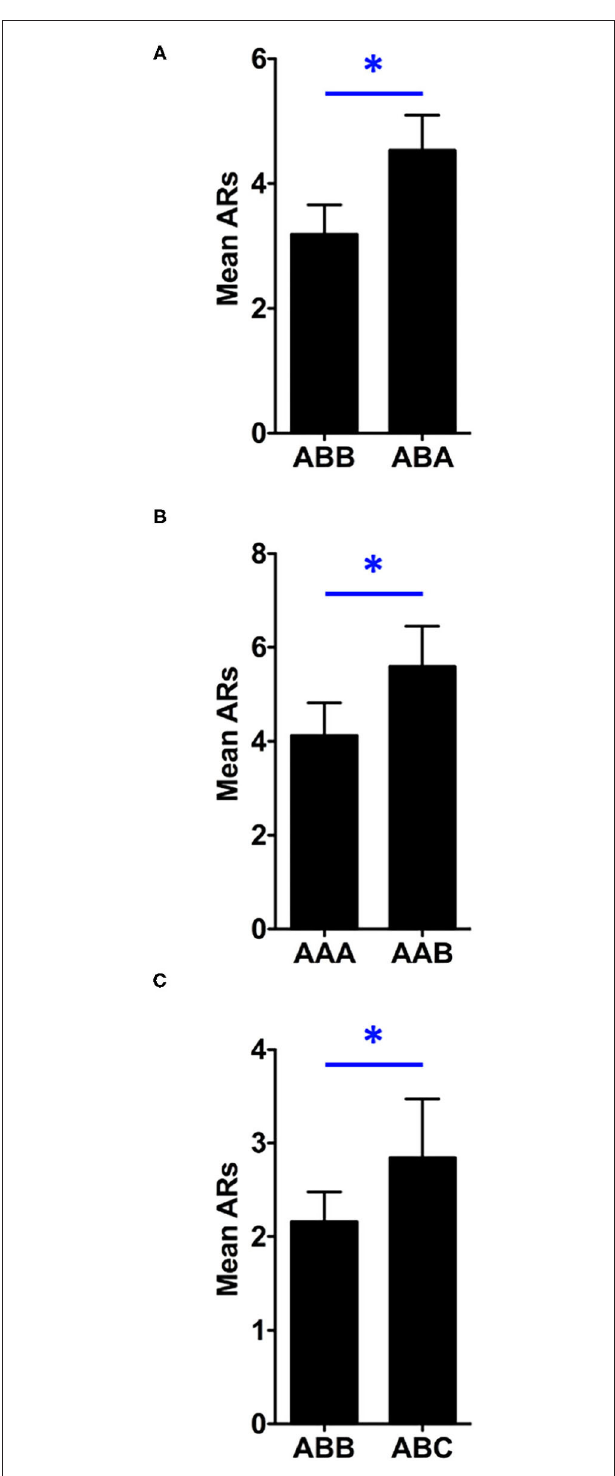
FIGURE 3 | Test data are collapsed across tone and noise and expressed as a function of the stimulus role during each test resulting in the comparisons of ABB vs. ABA (A) , AAA vs. AAB (B) and ABB vs. ABC (C) . Similar to the extinction data, all shuttles during the CSs were counted since no response contingencies were in effect (i.e., the tests were conducted under extinction). Asterisks represent significance at the 0.05 alpha level and error bars,